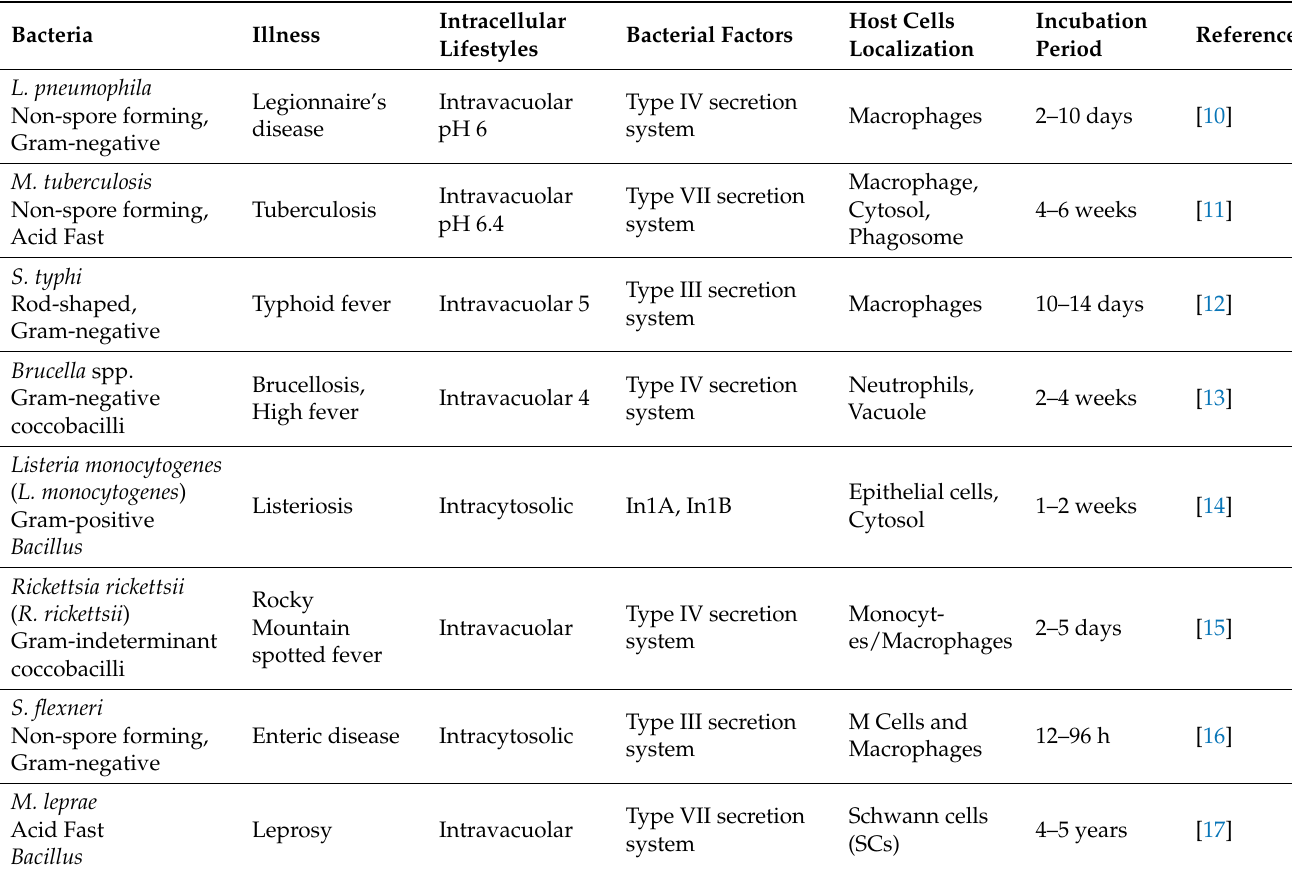
Table 1. Summary of intracellular bacteria, associated illnesses, host cells, and incubation